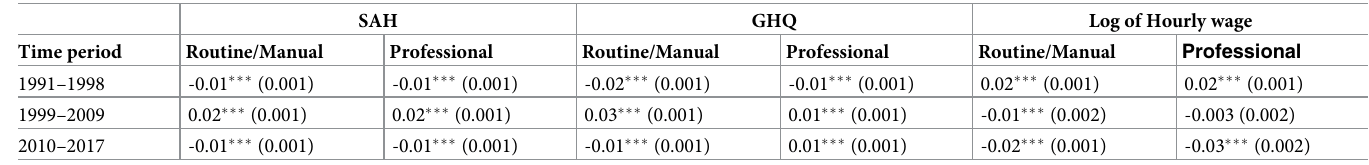
Table 4. Trends in the intergenerational correlation in SAH, GHQ and log of hourly wage by parental occupation over the period 1991–2017.